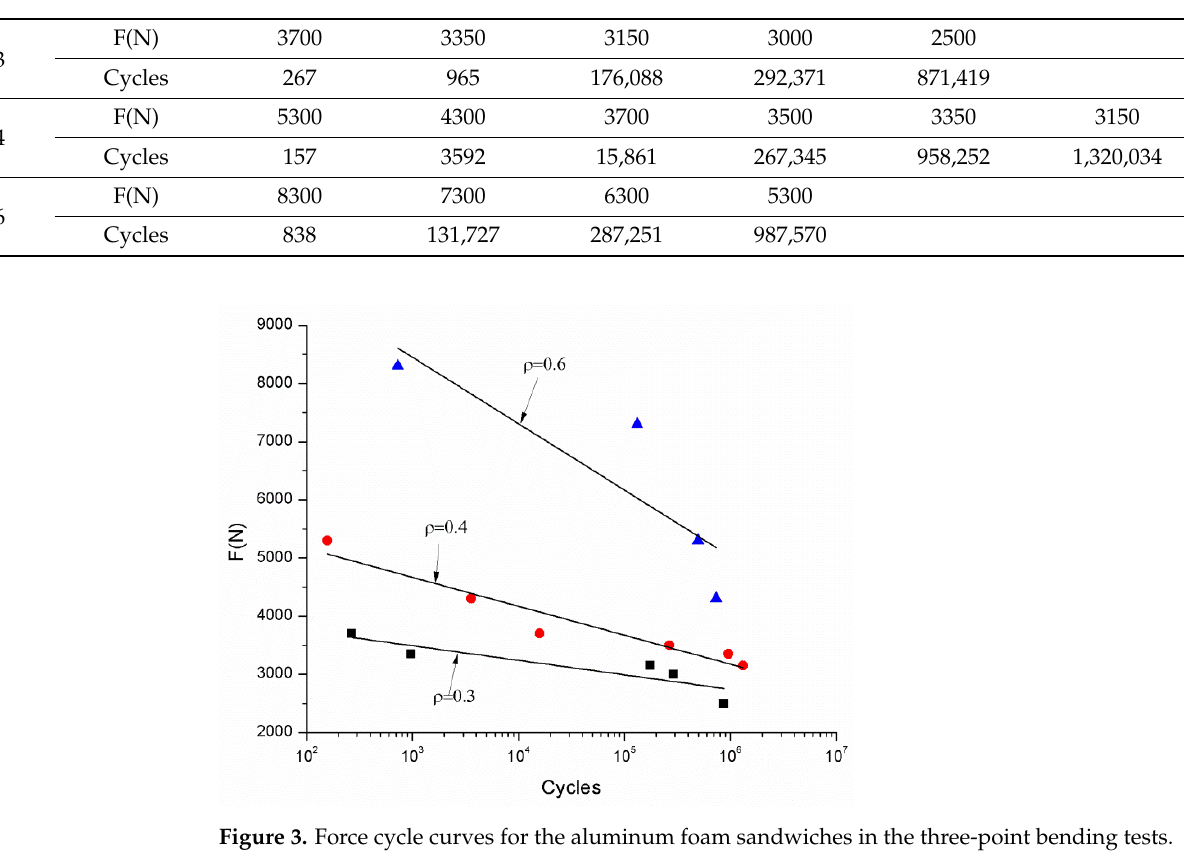
Table 3. Experimental results of the fatigue tests of the aluminum foam sandwiches.